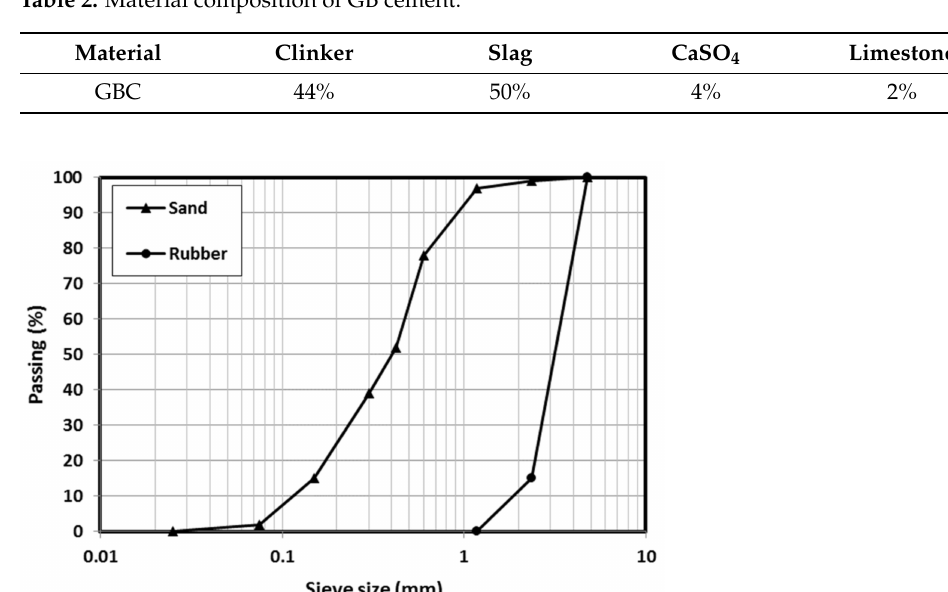
Table 2. Material composition of GB cement.